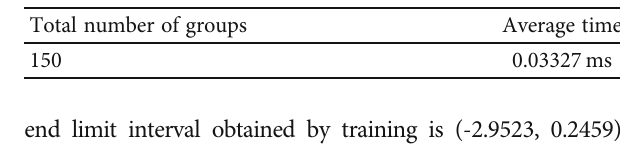
Table 4: Average time for weight loss feature